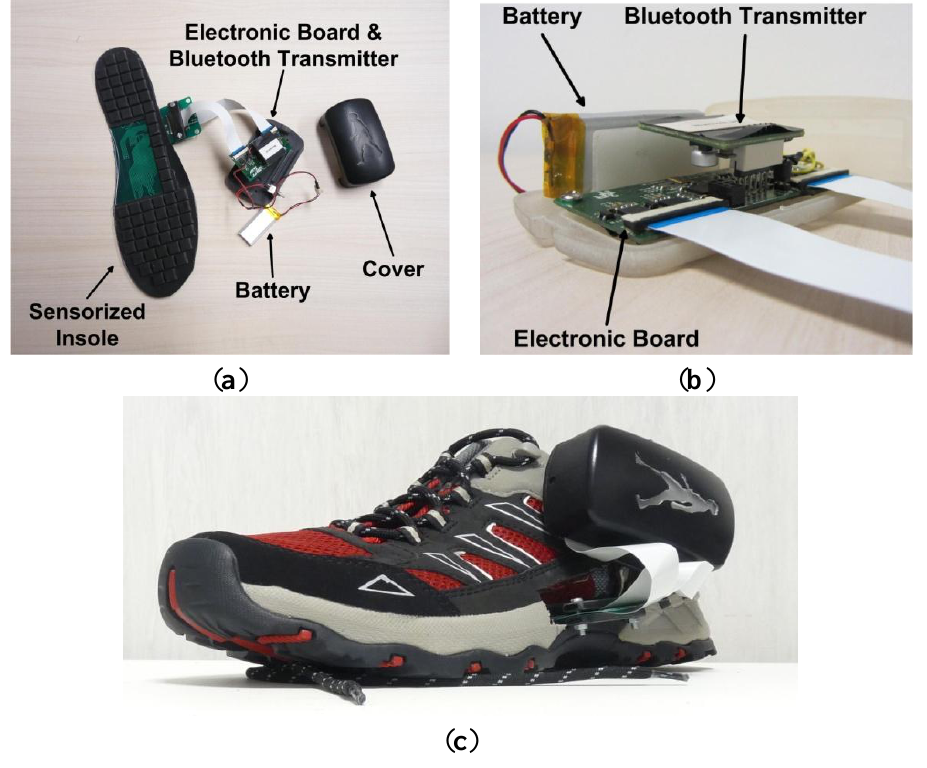
Figure 3. ( a ) Overview of the device: sensorized insole connected to the electronic board through flat cables, Bluetooth transmitter, Li-Ion battery; ( b ) detail of the electronic board and Bluetooth transmitter connected together and placed into a box; ( c ) overview of the device set up into the